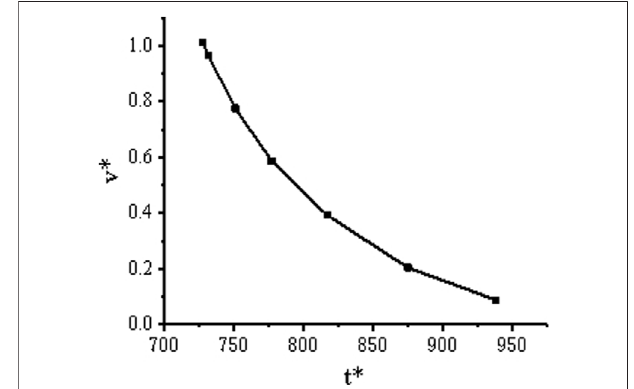
FIGURE 10 | Dimensionless transmission speeds at different formation